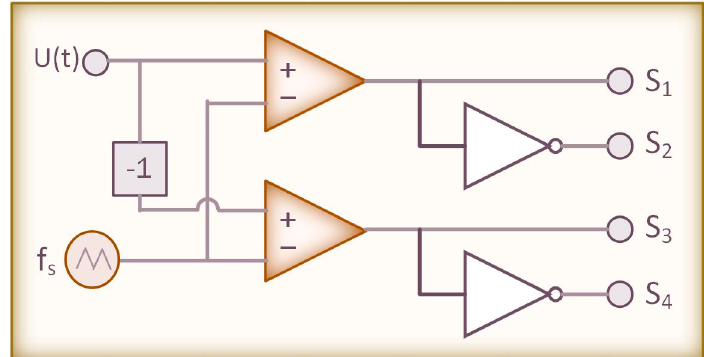
Figure 14. Control for the DC–AC converter working as a